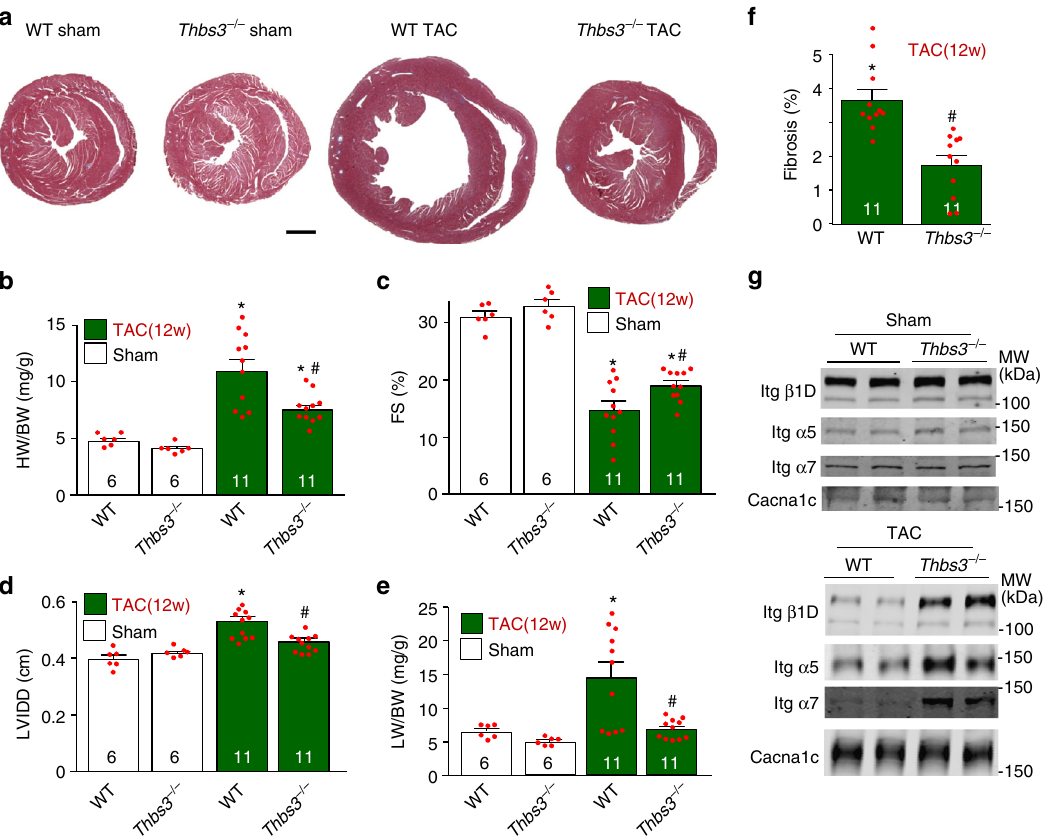
Fig. 4 Loss of Thbs3 protects the heart from pressure overload pathology. a Low magni fi cation cardiac histological images from WT and Thbs3 − / − mice stained with Masson ’ s trichrome 12 weeks after TAC or sham surgery. Scale bar = 1 mm. b HW/BW ratios in the indicated groups of mice 12 weeks